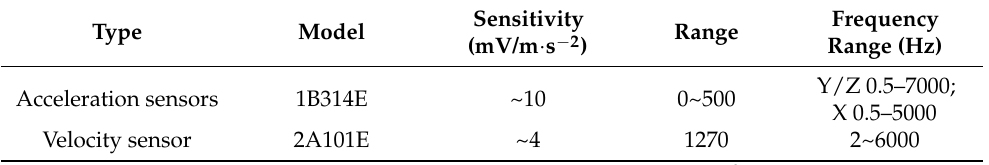
Table 1. Sensor specifications.